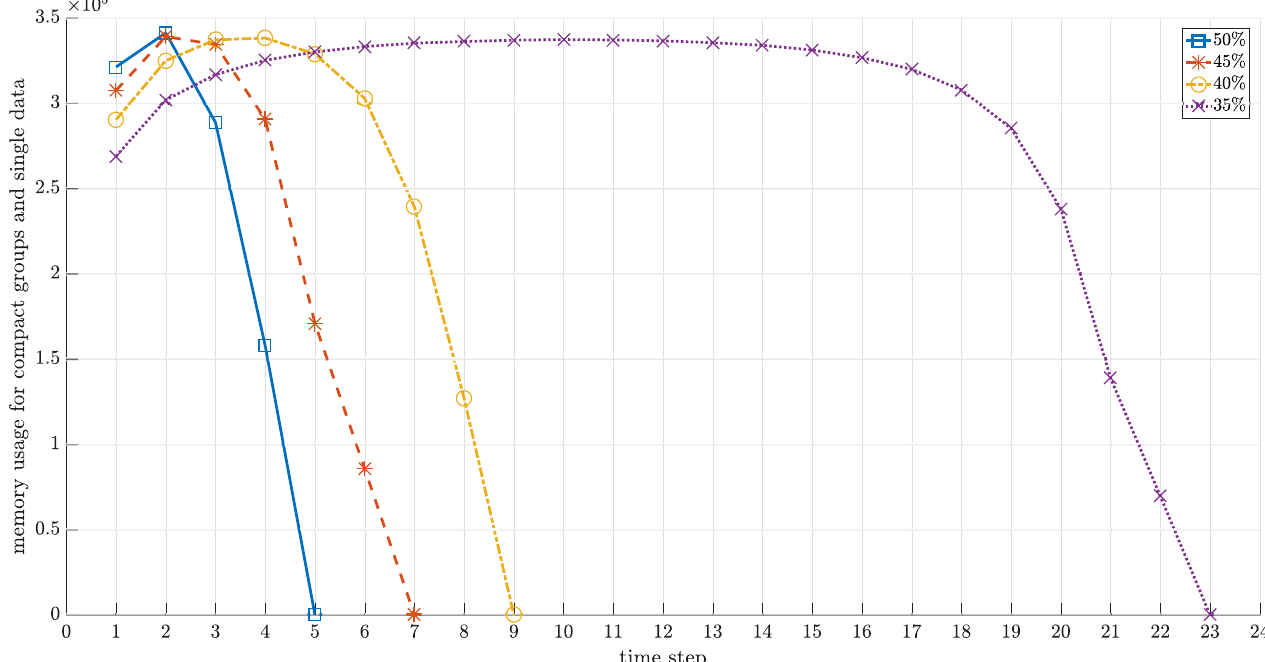
Fig 4. Fluctuation in number of compact groups and single data for the proposed algorithm at several memory sizes for one million data points.